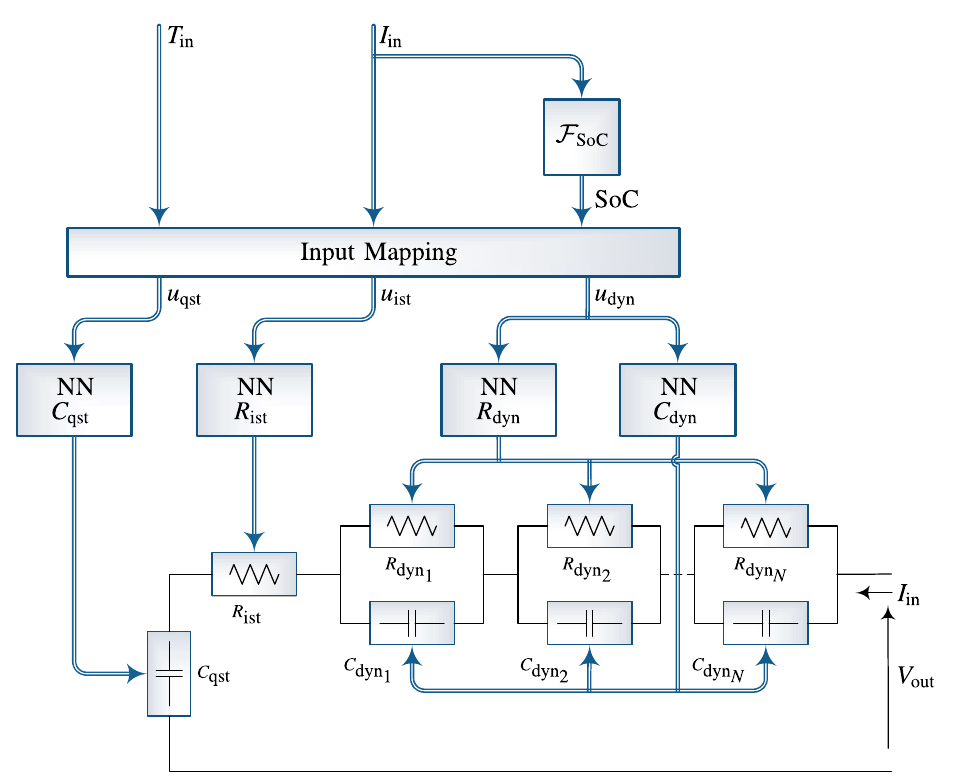
Figure 6. ENNC model adaptation to the ECM. The state equations shown in Equation (20) are described according to A ∈ R M ×